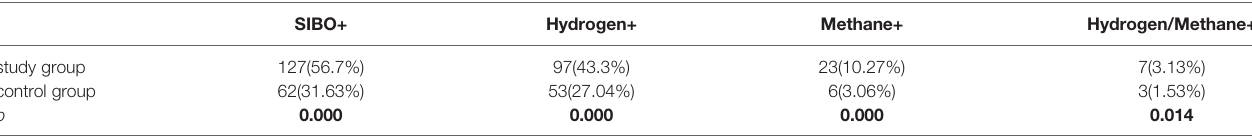
Boldface indicates statistical signi fi